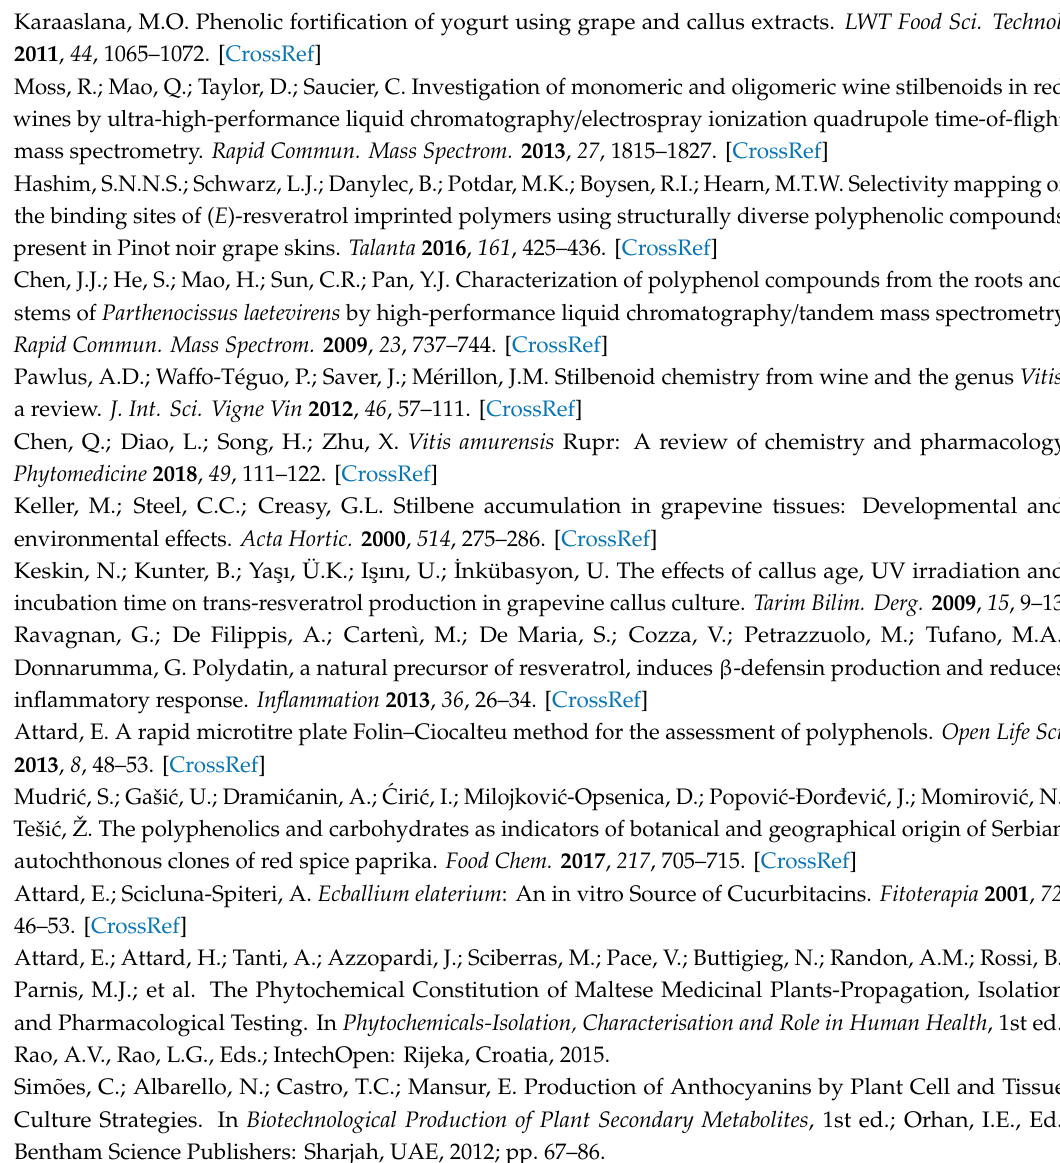
Sample Availability: Samples of the compounds gallic acid, protocatechuic acid, p -hydroxybenzoic acid, ca ff eic acid, vanillic acid, syringic acid, p -coumaric acid, ferulic acid, catechin, isoquercetin, myricetin, luteolin, and naringenin are available from the